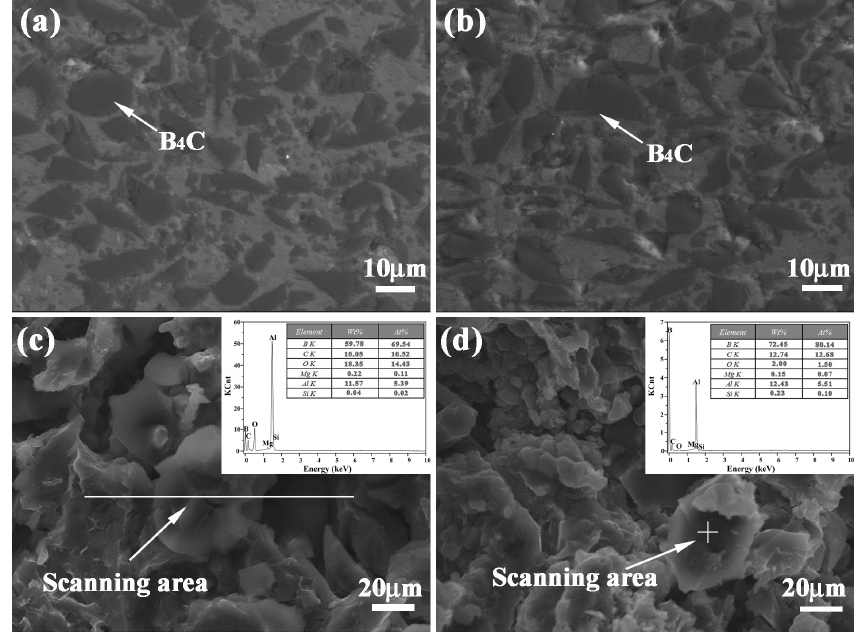
Figure 4. Metallography of inner layers in ( a ) Bionic Meretrix lusoria shell and ( b ) Rapana venosa shell layered composite materials, fracture morphology and EDS analysis of inner layers in ( c ) Bionic Meretrix lusoria shell and ( d ) Bionic Rapana venosa shell layered composite materials.